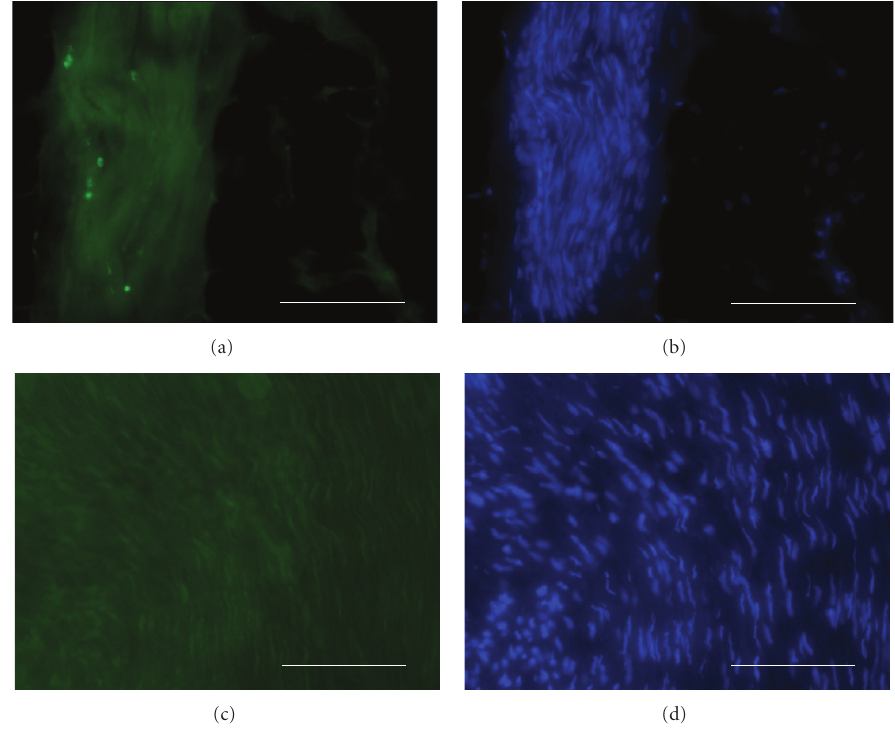
Figure 6: GFP lineage-labelling detection in DAPI-counterstained sagittal sections of venous bridges with (a, b) or without (c, d) transplantation of LV-GFP-labeled neurospheres, at 240 days after lesion. GFP-expressing neurosphere progeny (a, c) and DAPI-labeled tissue cell nuclei (b, d) are detected by fluorescence microscopy by using, respectively, adequate wavelengths. Scale bars: 0.5 mm (a, b), 100 μ m (c,